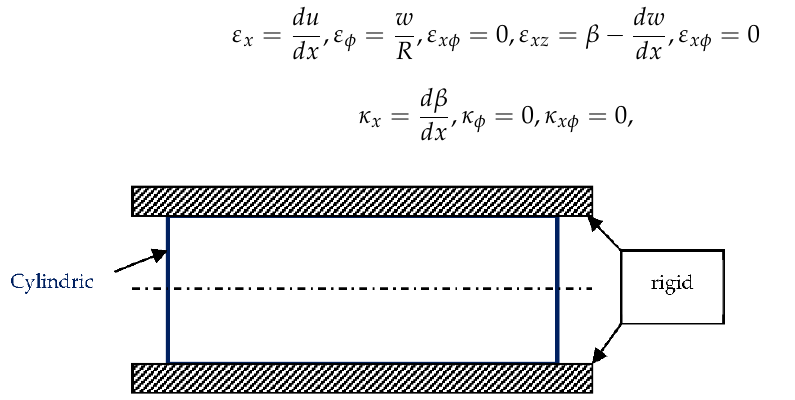
Figure 2. Axisymmetric cylindrical shell in the rigid housing.